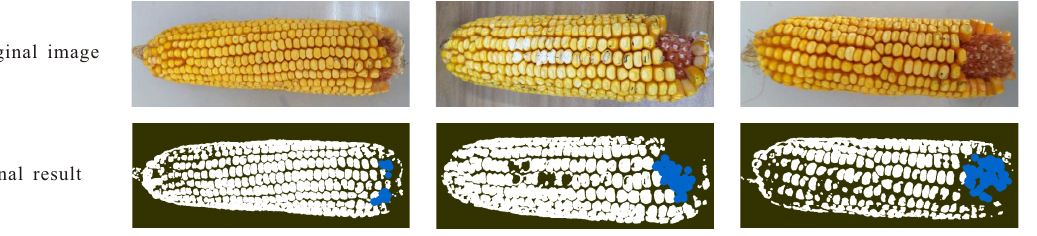
(cid:32) Figure 11. Final results on single ear damage